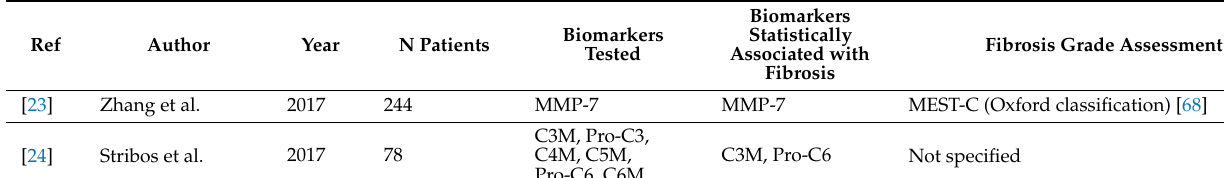
Table 3. Summary of the studies that included kidney biopsy in their analysis and their scores to assess the grade of